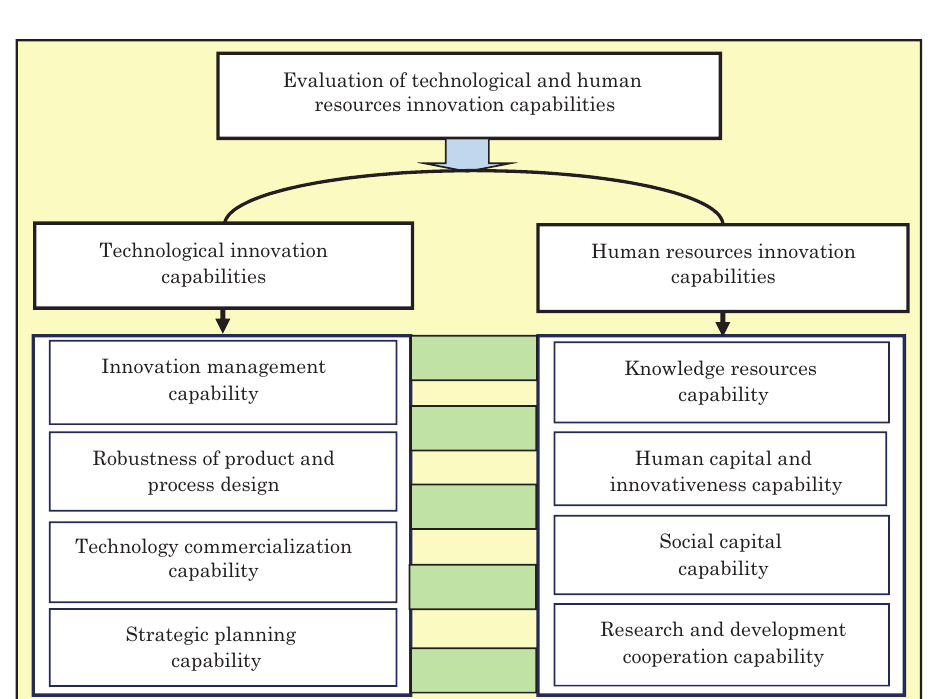
Fig. 3. Selected innovation capabilities based on Fuzzy